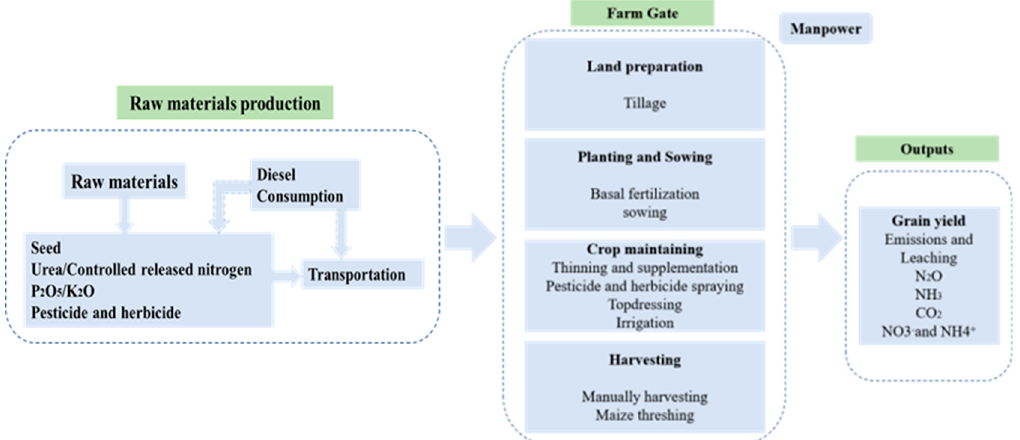
Figure 2. System boundary of the life cycle assessment for estimating the carbon footprint in maize production.